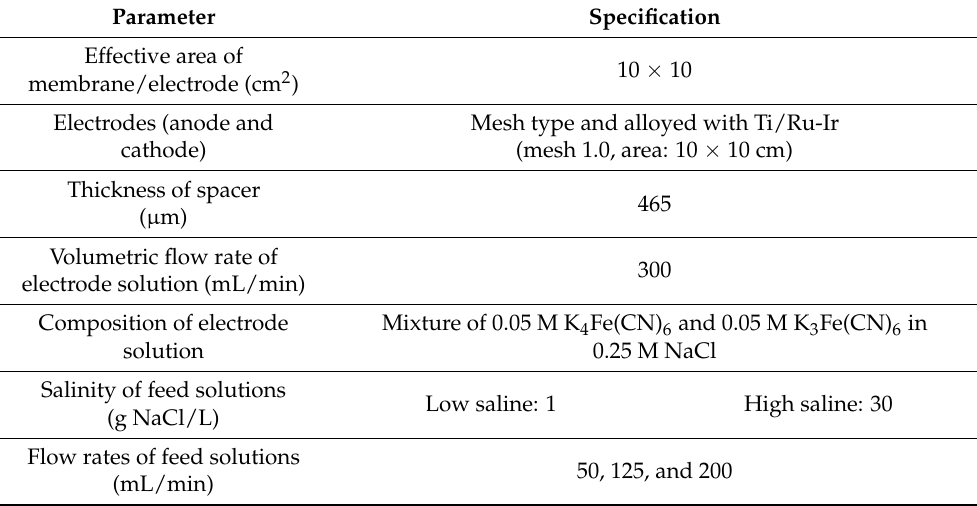
Table 2. Operating parameters of the RED